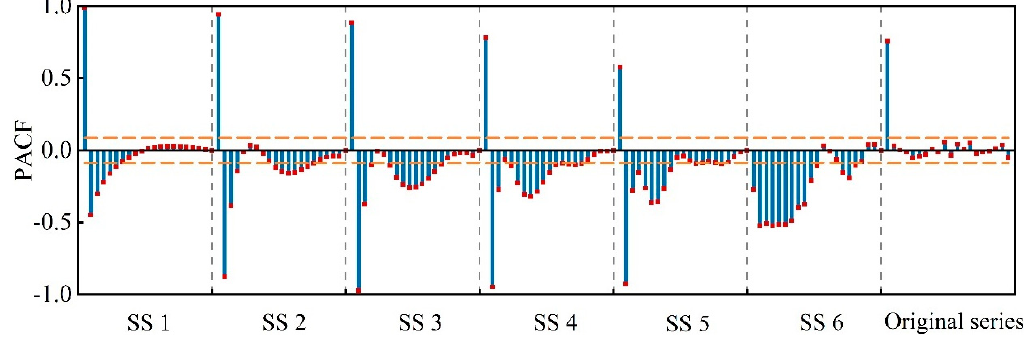
Figure 6. The PACFs of the original series and the subseries decomposed by EWT.